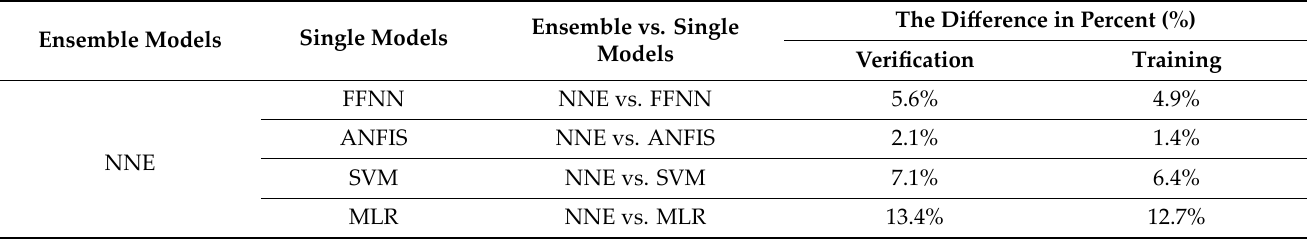
Table 6. The comparison of the prediction level of single AI models vs. non‑linear ensemble